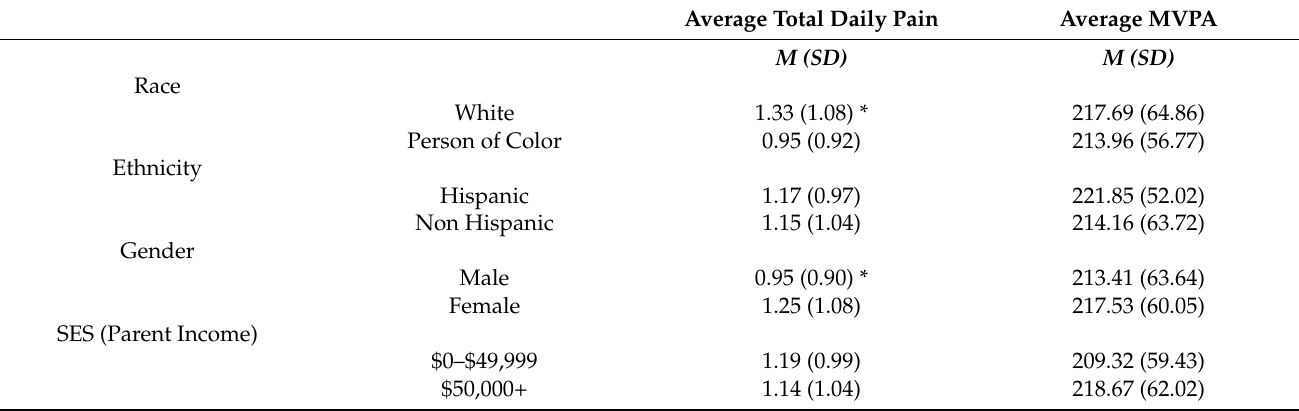
Table 2. Descriptive Results Pain and MVPA by Dummy-Coded